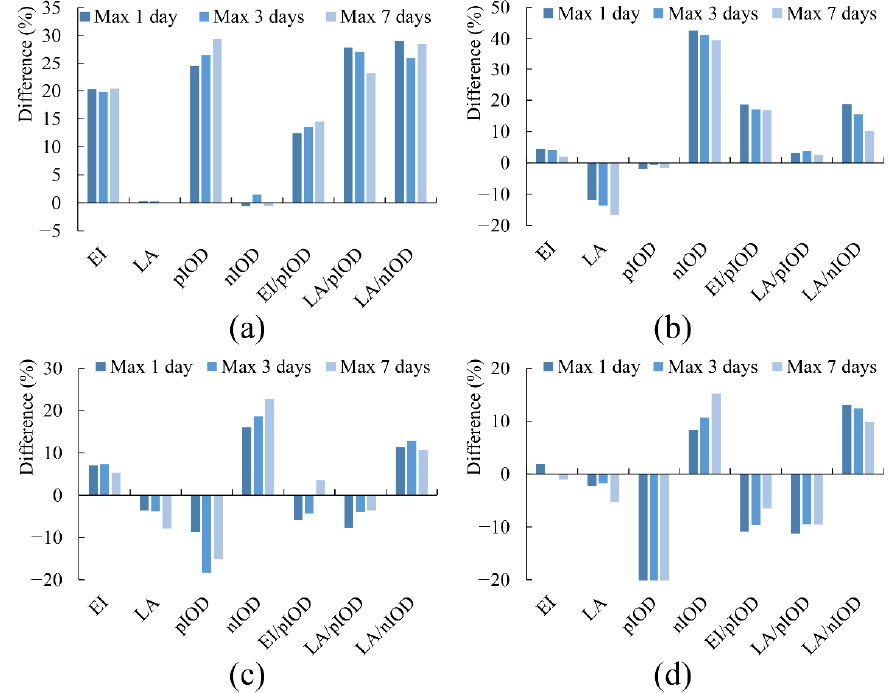
Figure 8. The difference in 1-day/3-day/7-day maxima streamflow relative to neutral years in developing years at ( a ) Zhimenda, ( b ) Shigu, ( c ) Tongzilin, and ( d ) Xiangjiaba. Note: Difference = (maximum streamflow in ENSO/IOD years—maximum streamflow in neutral years)/maximum streamflow in neutral years * 100.